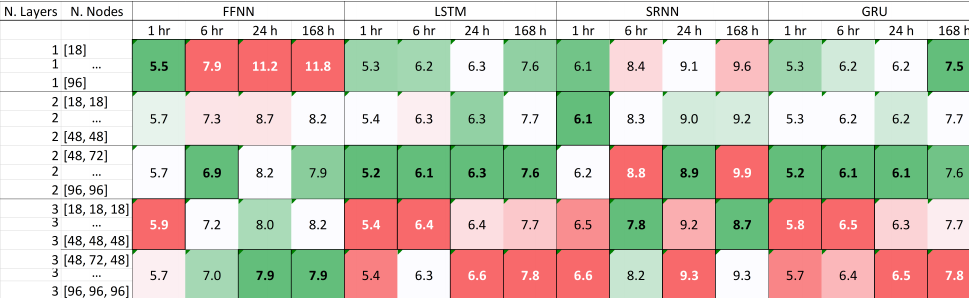
Figure 11. MAPE per group of models of ts 2 time series for each architectures on the 4 forecasting horizons with the set of inputs